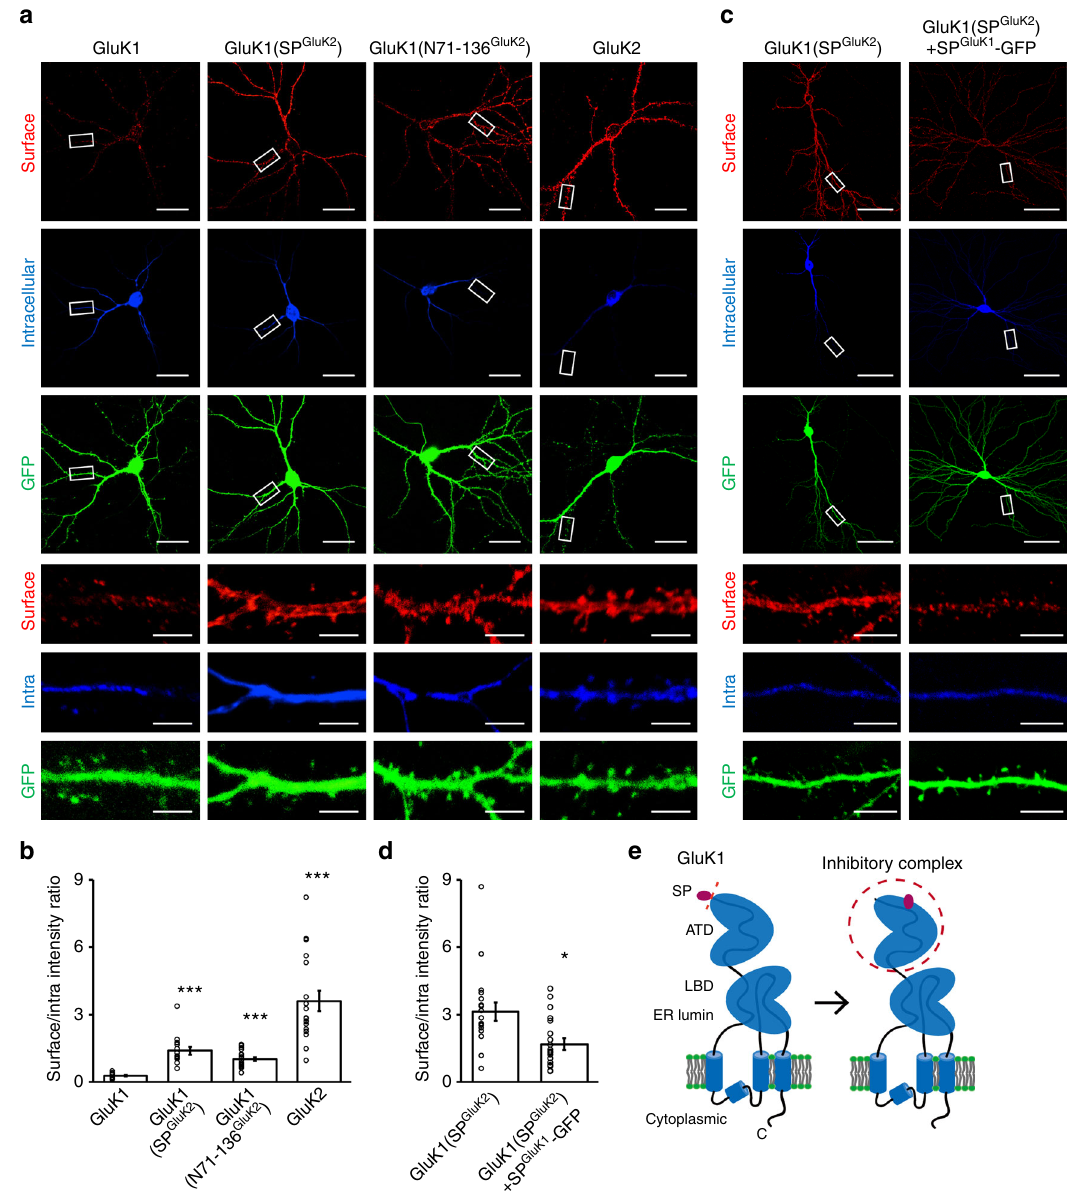
Fig. 5 GluK1 signal peptide and ATD control its receptor surface expression. a Representative images from cultured hippocampal neurons transfected with wild-type or chimeric kainate receptors as indicated. An HA-tag was inserted after the signal peptide for immunostaining analysis. Neurons were transfected at DIV12 and stained at DIV16-18. Plasma membrane (red) and intracellular (blue) expressed receptors were differentially labeled before and after permeabilization respectively. pCAGGS-GFP empty vector was co-transfected and used as a volume marker to visualize neuron morphology. Expanded images at the bottom of each panel are taken from the area indicated by white rectangles. Scale bar: 25 μ m (original) and 4 μ m (enlarged). b Quantitation of the relative expression of indicated receptors at neuronal surface to the entire cell, as calculated from the ratio of red to blue fl uorescence intensity. Bar graph, overlaid with the actual data points, shows the total results from three independent experiments (mean ± SEM): GluK1, n = 17, 0.29 ± 0.04; GluK1(SP GluK2 ), n = 14, 1.41 ± 0.18; GluK1(N71-136 GluK2 ), n = 19, 1.02 ± 0.08; GluK2, n = 18, 3.63 ± 0.46; *** p < 0.0001, Statistical analyses are comparisons to GluK1 with Mann – Whitney U -test. c Surface and intracellular expression of GluK1(SP GluK2 ) (HA-tagged after signal peptide, left panels) or SP GluK1 -GFP cotransfetion (right panels) as indicated. Expanded images at the bottom of each panel are taken from the area indicated by white rectangles. Scale bars: 50 μ m (original) and 5 μ m (enlarged). d Quantitative analysis for c (mean ± SEM): GluK1(SP GluK2 ), n = 19, 3.15 ± 0.41; GluK1(SP GluK2 ) + SP GluK1 - GFP, n = 20, 1.70 ± 0.25; * p < 0.05. Data are analyzed using Mann – Whitney U -test. e The working model of GluK1 showing the signal peptide and